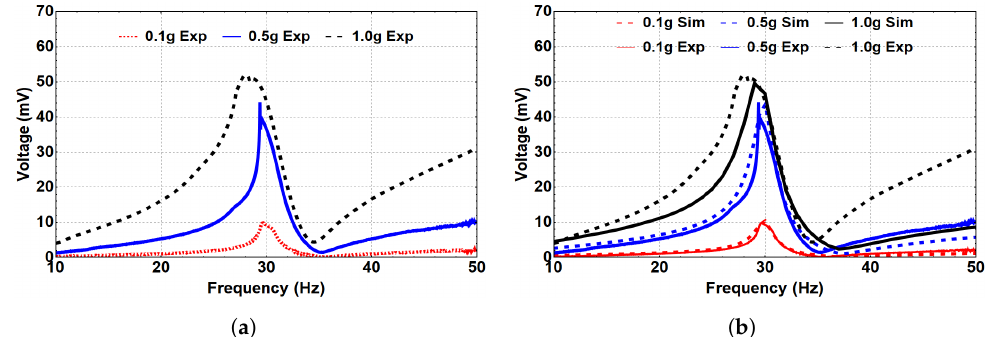
Figure 8. The frequency–voltage curve for different excitation levels at the bistable regime ( d = 8 mm). ( a ) Experimental results. ( b ) Simulated results with experimental validation.